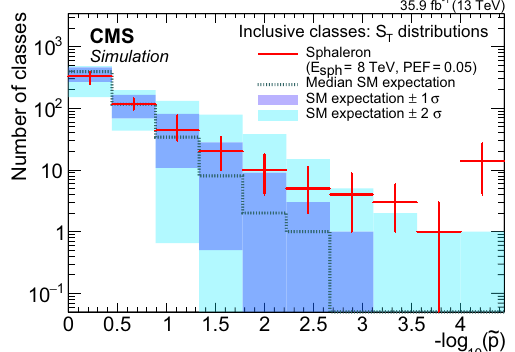
class that contained data but no simulated events at all.